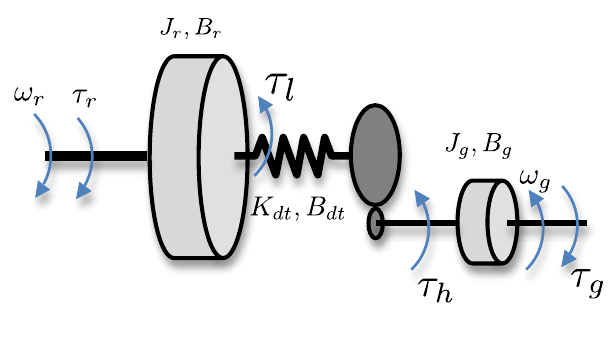
Figure 2. Schematic diagram of drive